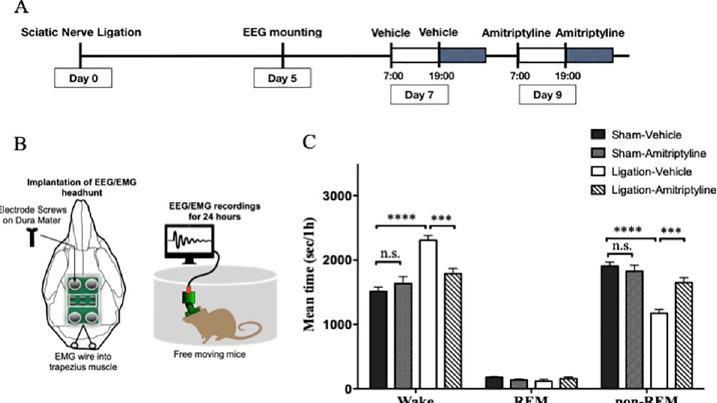
Fig 3. Amitriptyline improved quantity of sleep in neuropathic pain model. EEG and EMG were recorded for 24 hours with administration of vehicle (test day 7) and amitriptyline (test day 9) (A). Schematic diagram of EEG/EMG implantation (B). The mean value per hour of wake, REM sleep, and non-REM sleep time are represented for the sham (n = 7) and nerve ligation groups (n = 7) (C). Data are expressed as means ± SEM. Data are analyzed using two-way ANOVA followed by Bonferroni’s post hoc test and considered statistically significant at ��� P < 0.001, and ���� P < 0.0001 when comparing the groups.